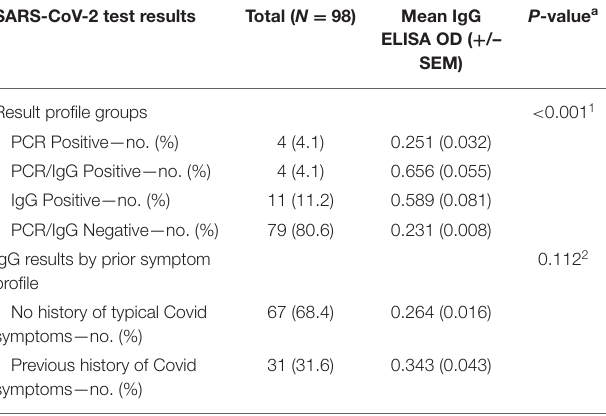
TABLE 2 | IgG ELISA optical densities of frontline healthcare workers tested for SARS-CoV-2. SARS-CoV-2 test P - Total Positive a Negative ( n = 98) ( n = 19) ( n = 79) value b